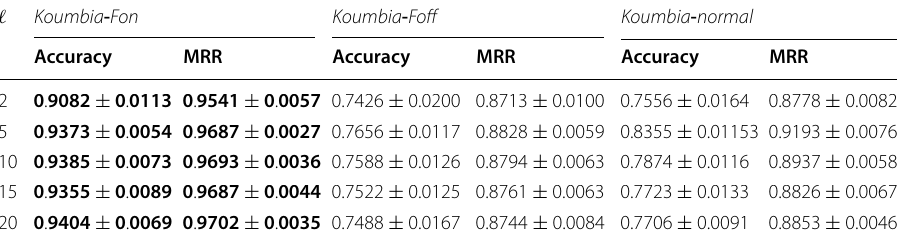
Table 11 Performance of ML-GAT over the Koumbia multilayer networks with varying number of layers, and different types of input features